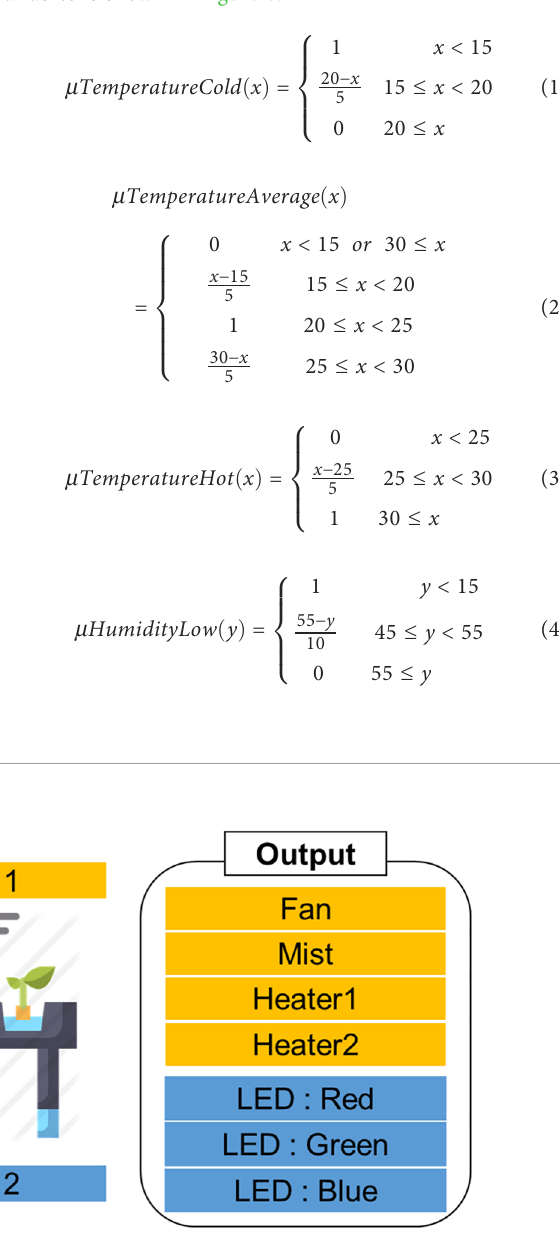
FIGURE 5 Schematic design of the input and output